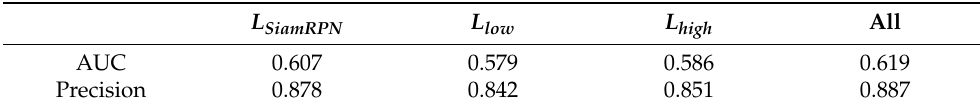
Table 8. The impact of different loss terms on five